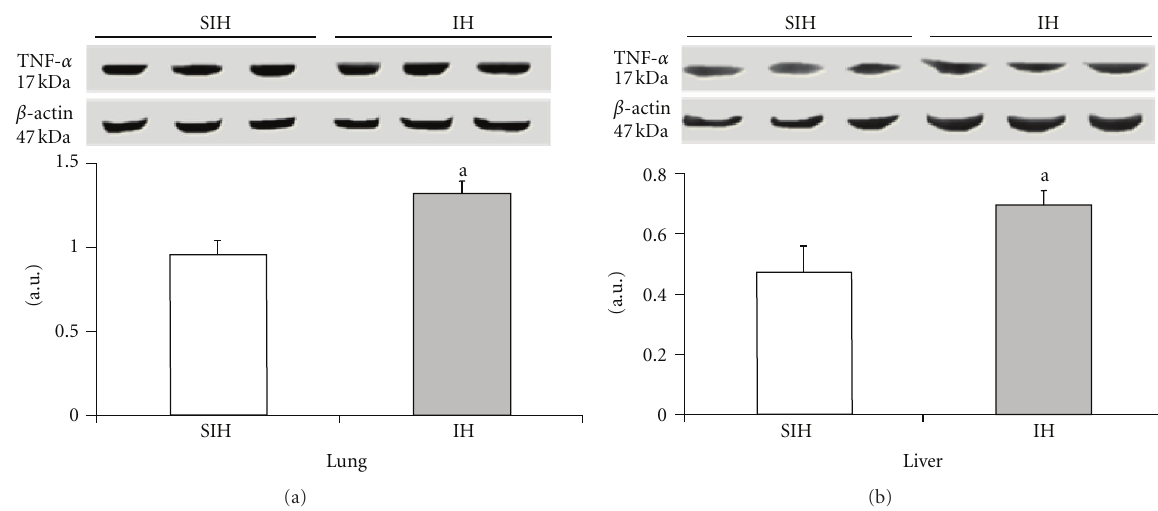
Figure 3: The e ff ect of intermittent hypoxia on the expression of TNF- α in the liver ((a), P = 0 . 0382) and lung ((b), P = 0 . 0171). Results are reported as mean ± standard error, n = 6 per group. P value according to Student’s t